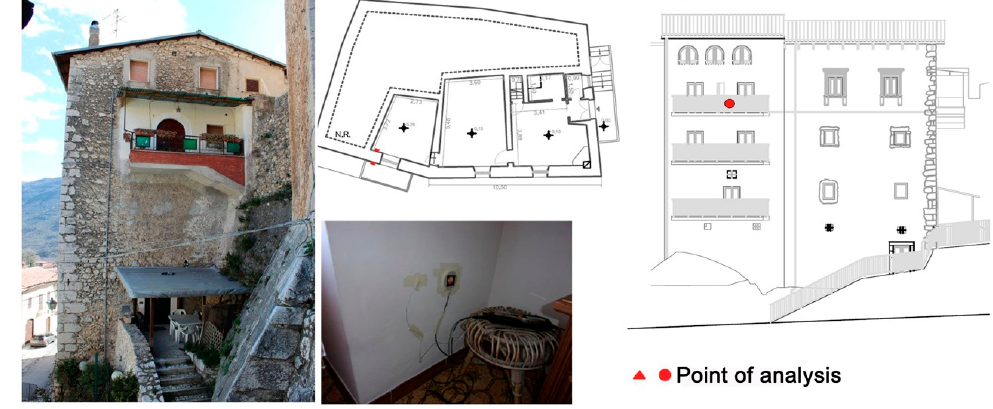
Figure 9. Point where the measurement was performed.